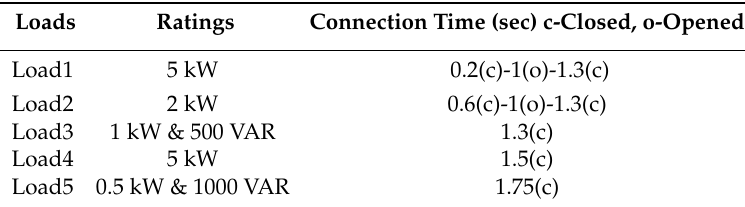
Table 4. AC load connection